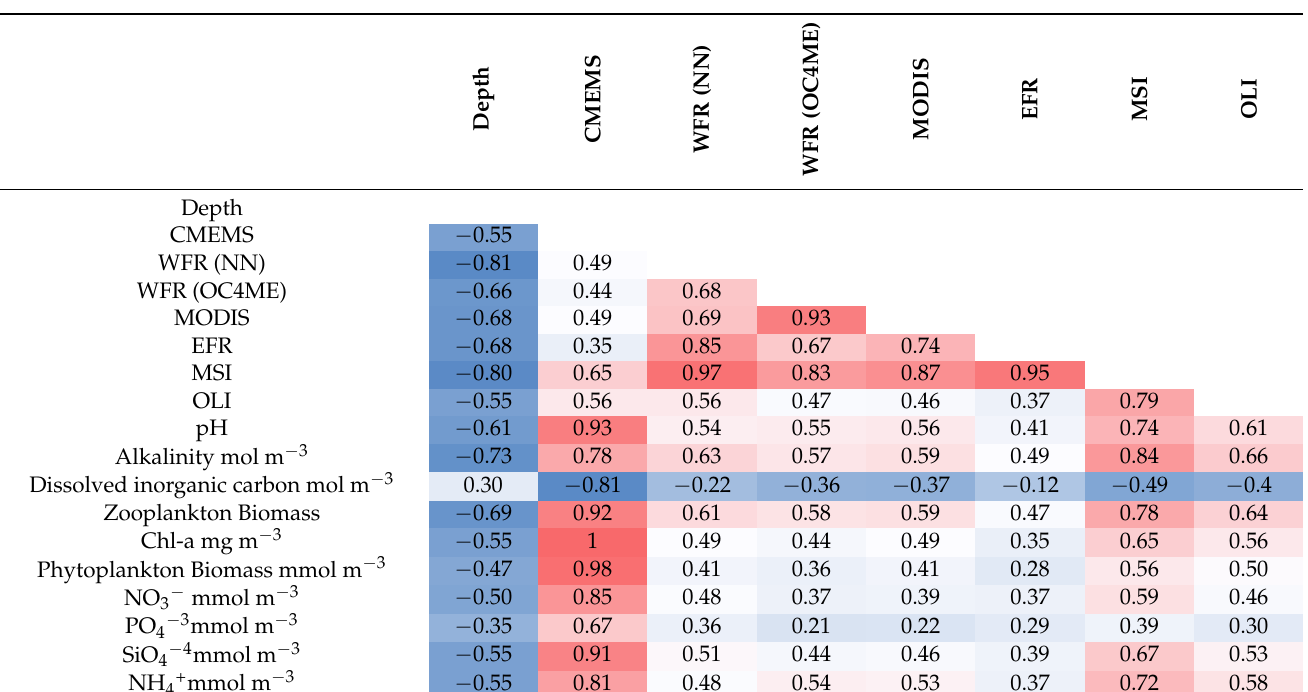
Table 5. Pearson’s correlation coefficients among estimated and reference Chl- a contents and coastal water geochemistry (CMEMS).